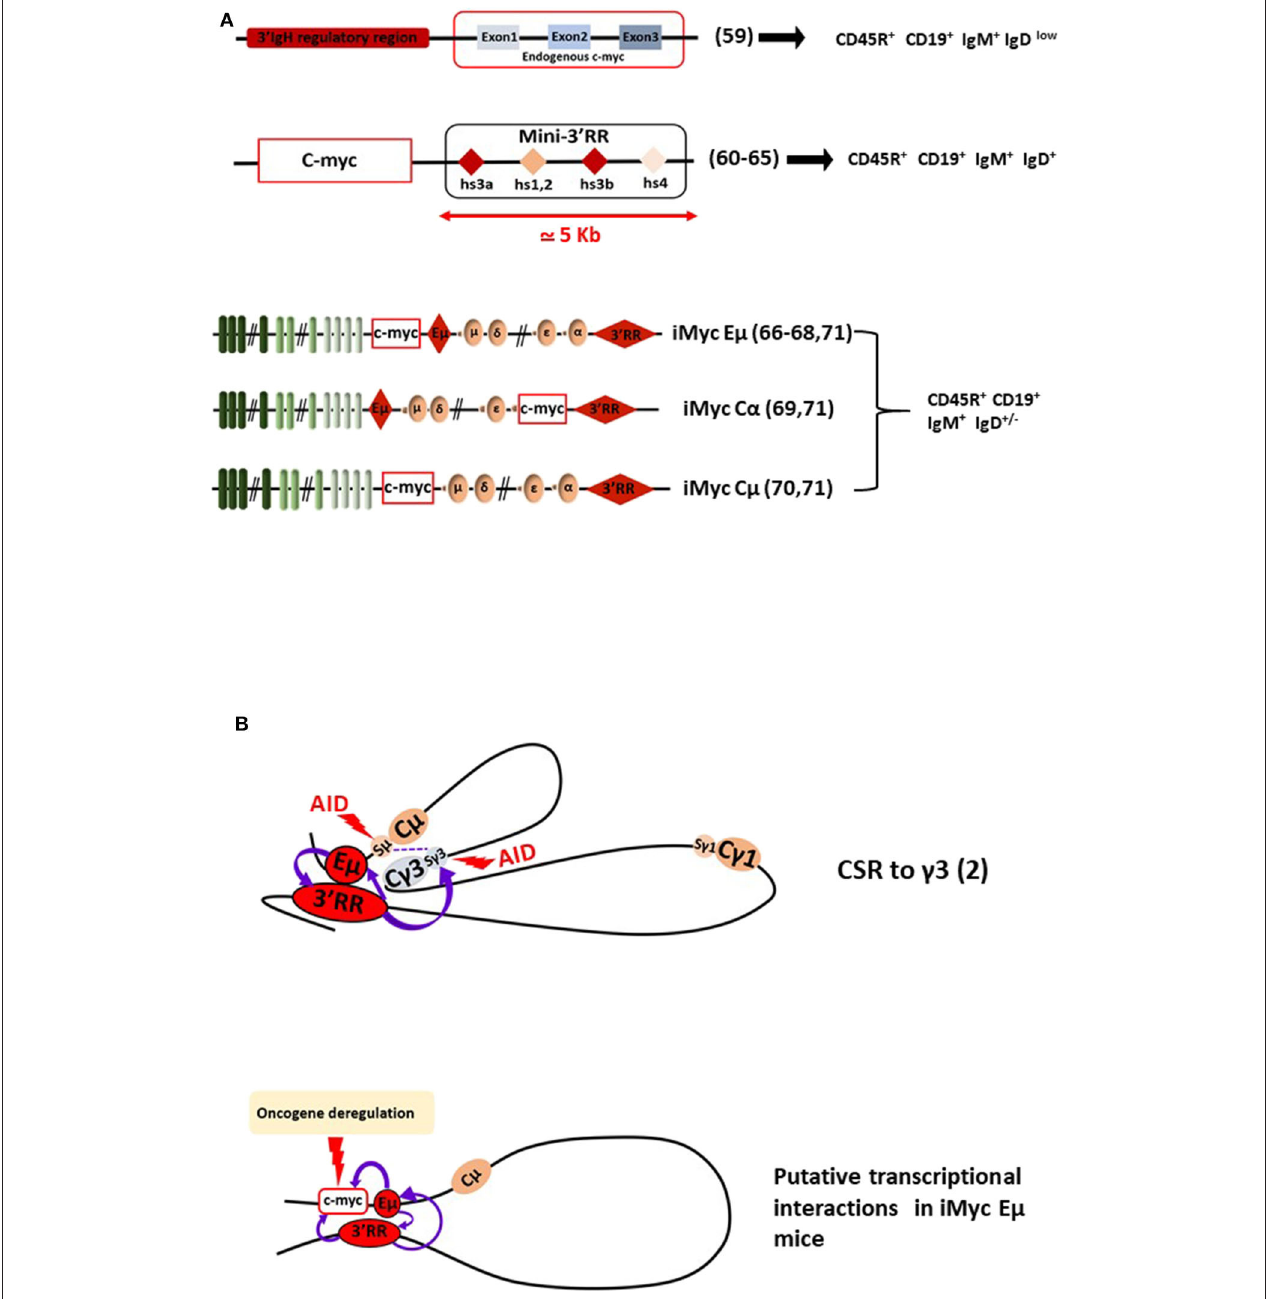
FIGURE 2 | The 3’RR and B-cell lymphomagenesis. (A) Schematic representation of several transgenic mouse models reporting c-myc 3’RR-driven deregulation leading to B-cell lymphomagenesis. B-cell lymphoma phenotypes are reported. Bibliographic references are reported (number in parenthesis). The “Mini-3’RR” contains the four transcriptional enhancers hs3a, hs1,2, hs3b, and hs4 but not the 3’RR palindromic sequences flanking hs1,2 and the DNA sequence between hs3a and hs4. (B) Long-range loop interactions between chromatin segments of the IgH locus comprise the mechanism of normal gene transcription regulation by the E µ and 3’RR transcriptional enhancers. The example of the IgG 3 CSR process is schematized. Putative long-range interactions leading to c-myc oncogene deregulation in iMycE µ mice are